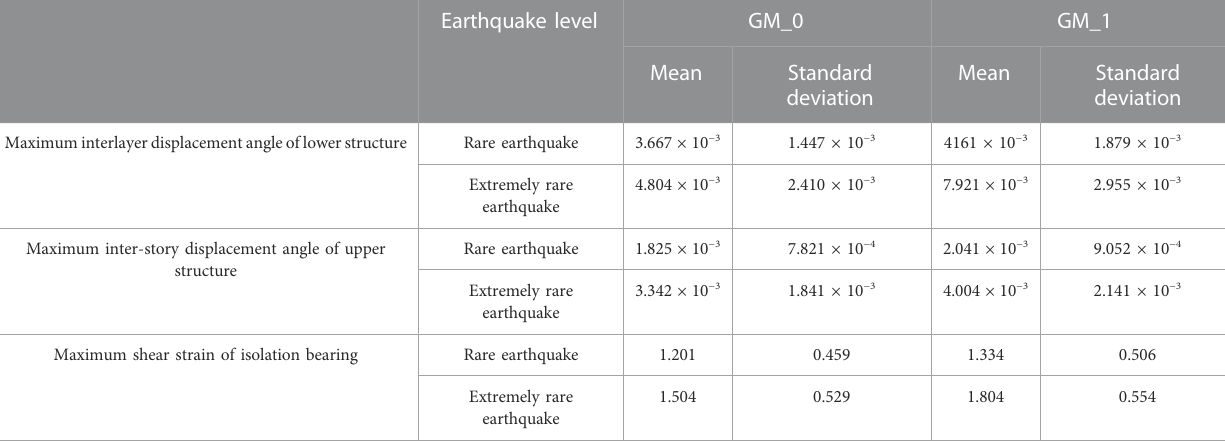
TABLE 6 Probabilistic characteristic parameters of structural response values of the isolation layer set in the seventh